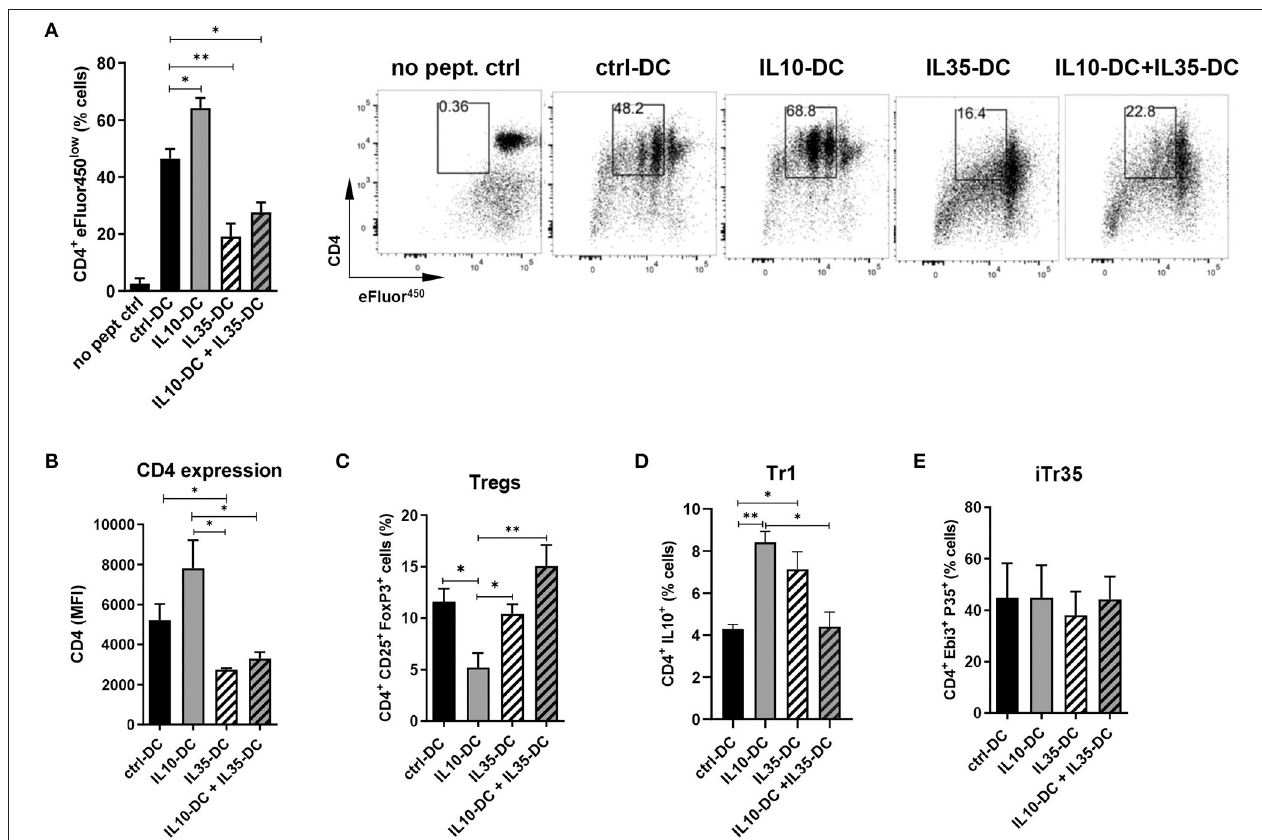
FIGURE 2 | The combination of IL10-DC and IL35-DC did not increase regulatory T cell populations in OVA-specific T cell cultures. 5 × 10 3 DCs were seeded in 96-well plates and pulsed with OVA 323 − 339 peptide for at least 2h before the addition of 5 × 10 4 naïve eFluor 450 -labeled OT-II CD4 + T cells. IL10-DC and IL35-DC lines, when added together, were mixed in equal dilutions before the seeding. Flow cytometric analysis of (A) cell proliferation, (B) CD4 expression (given in Median Fluorescence Intensity, MFI, of GFP − gated cells), (C) Tregs, determined as CD4 + CD25 + FoxP3 + of GFP − gated cells, (D) Tr1, determined as CD4 + IL10 + of GFP − gated cells, and (E) IL35-secreting Tregs (iTr35), determined as CD4 + EBI3 + P35 + of GFP − gated cells. Data are representative of at least three independent experiments. * P < 0.05; ** P <